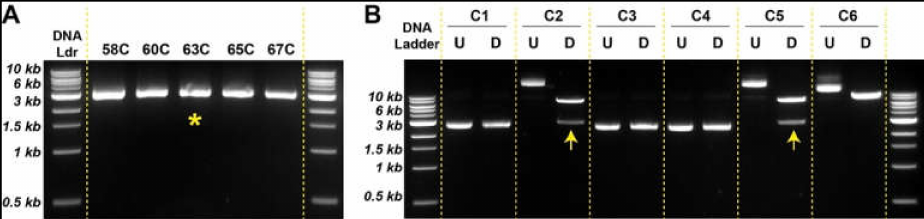
Figure 4. Generation of new lentiviral plasmids allows HA-tagged proteins ( A ). Optimum annealing temperature is determined to synthesize insert (HA.EPHA3). The most advantageous tested condition is indicated with a yellow asterisk ( B ). Restriction digestion with XhoI and EcoRI identified the newly engineered pLVX.HA.EPHA3 plasmids with correct DNA sizes (indicated by an arrow).